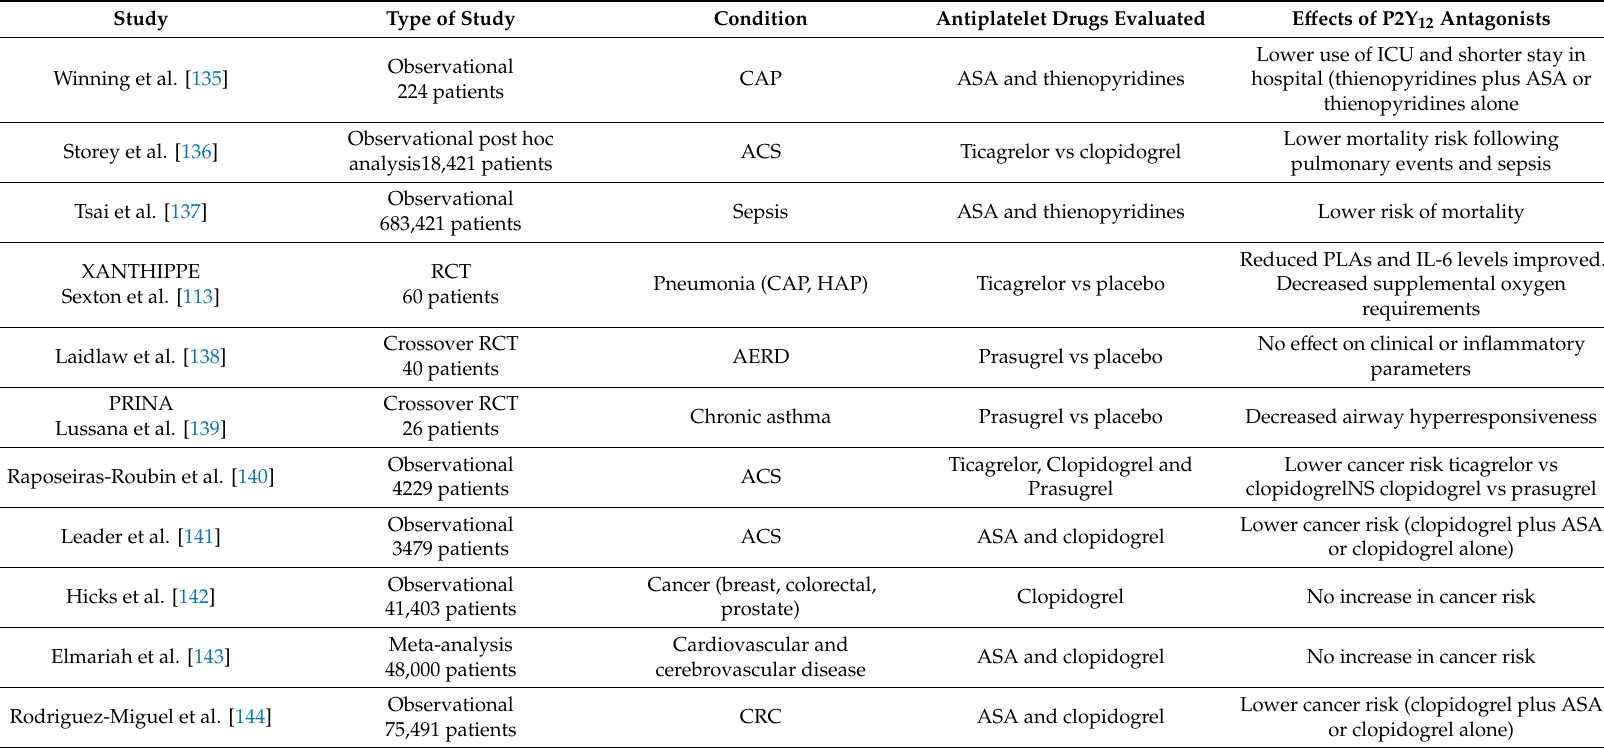
Table 2. Clinical studies investigating anti-inflammatory e ff ects of P2Y 12